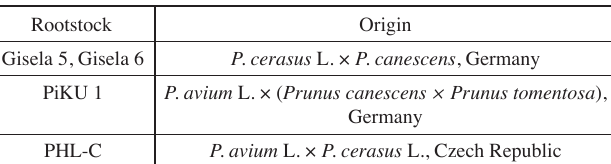
Tab. 1: Tested rootstocks and their origin